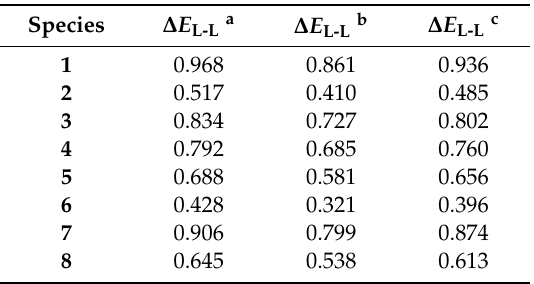
Table 2. The calculated ∆ E L-L values for 1 – 8 at the PBE0 / 6-31G (d,p). Species ∆ E L-L a ∆ E L-L b ∆ E L-L